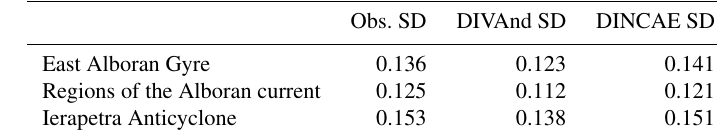
Table 3. Maximum standard deviation in three selected areas.